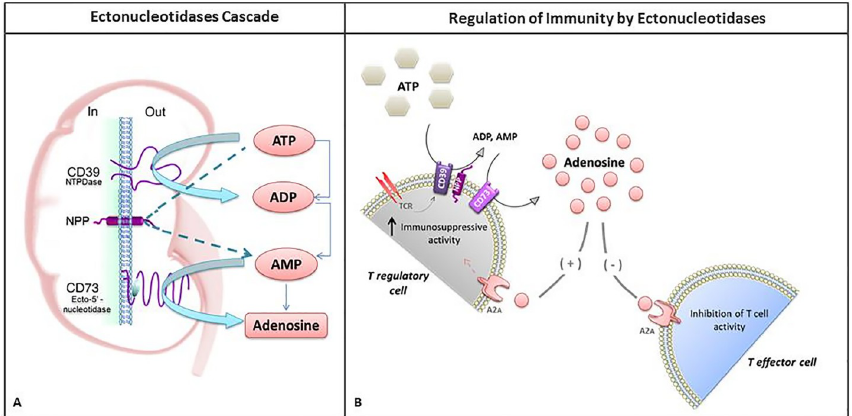
Fig 2. (A) Ectonucleotidases cascade– Members of the NTPDase (CD39) family are cell membrane enzymes that hydrolyze ATP into ADP as well as ADP into AMP through three different steps. In contrast, NPPs are able to degrade ATP and ADP into AMP in a single step, releasing AMP. In the final hydrolyzation step, the extracellular AMP can then be hydrolyzed to adenosine and inorganic phosphate (Pi) by the effect of Ecto-5 0 -nucleotidase (CD73). (B) Regulation of immunity by ectonucleotidase cascade– The occurrence of pathological insults, such as AR, activates T cell receptors (TCR) expressed in T regulatory cells (Treg), which induces CD39/CD73 activity leading to adenosine generation. Increased levels of extracellular adenosine promote immunosuppressive and anti-inflammatory activity in Treg cells. Also, through its receptor A2A in the T effector cell, adenosine suppresses T cell immunity by inhibiting activation of T effector cells. Thus, by employing different mechanisms on Treg and T effector cells, adenosine promotes an immunosuppressive